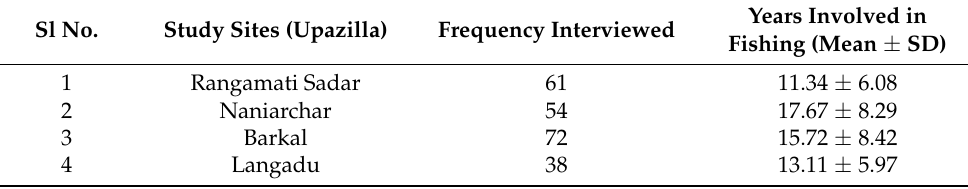
Table 5. Average fishing experience of the